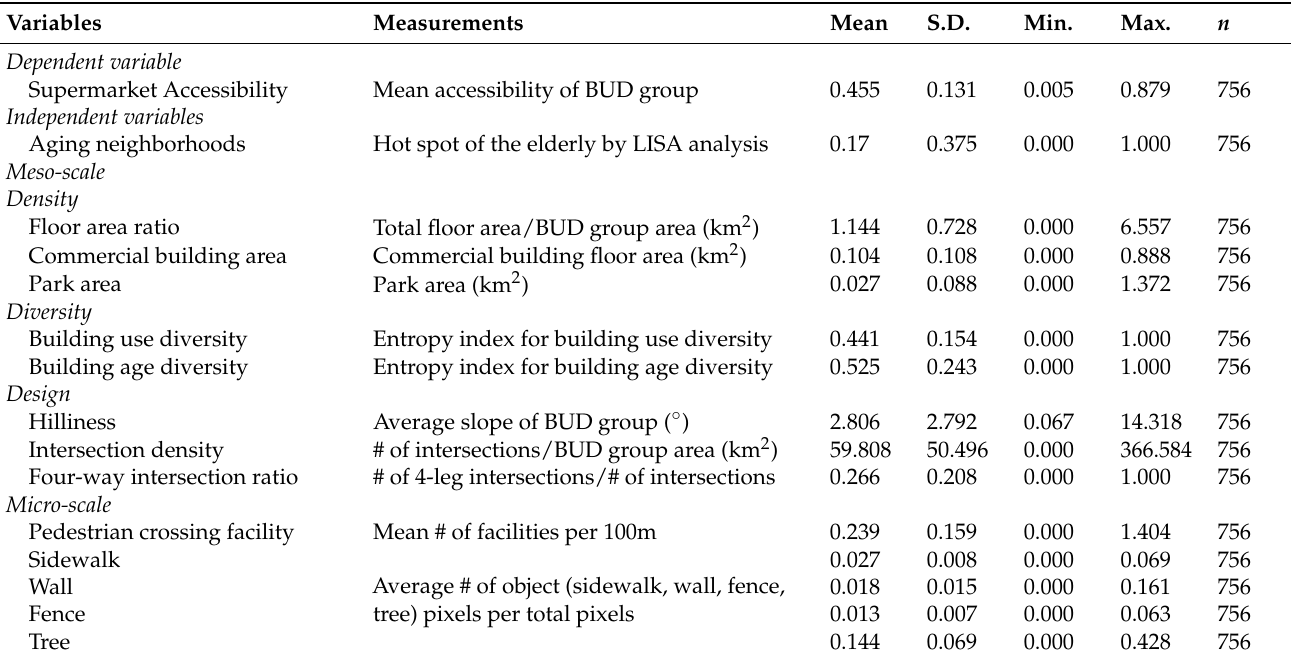
Table 1. Measurements and descriptive statistics of